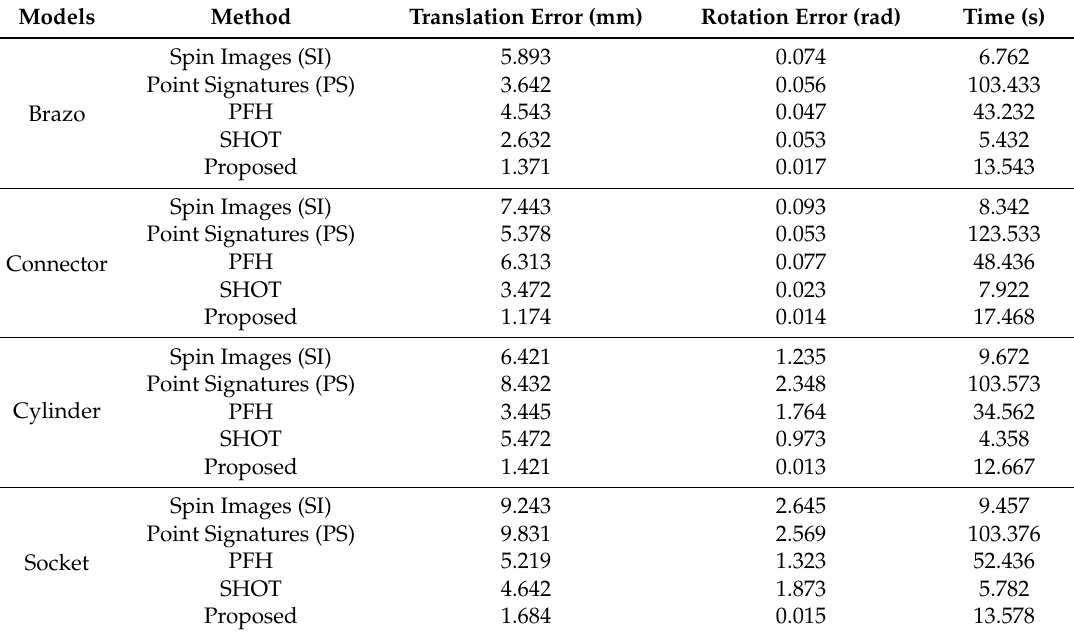
Table 4. Experimental results using synthetic data obtained by the proposed method and local feature descriptor methods.